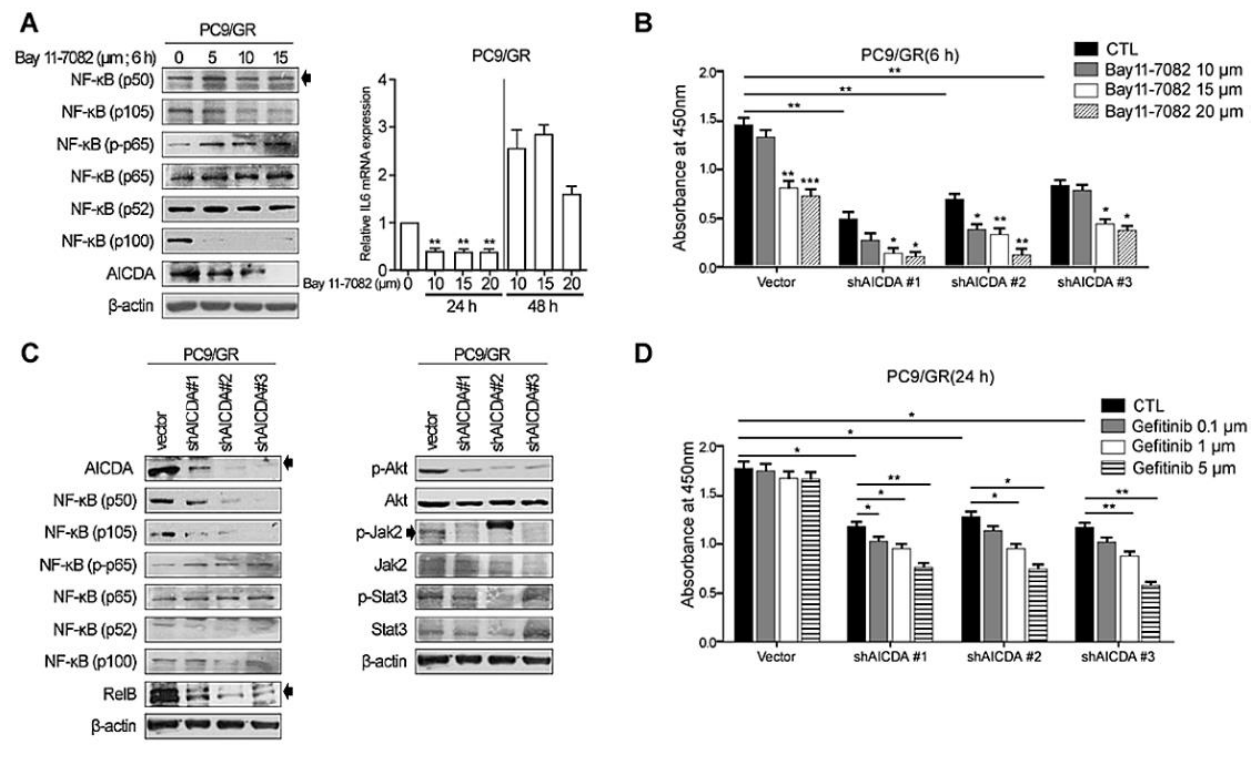
Figure 2. Knockdown of NF- κB and AICDA activity in EGFR -TKI-resistant lung adenocarcinoma cells. ( A ) Treatment of EGFR-TKI-resistant PC9/GR cells with an NF- κB inhibitor (Bay 11-7082), and changes in expression of ( A ) NF- κB components and IL -6. ( B ) Cell viability assay conducted after knockdown of AICDA. ( C ) Knockdown of AICDA and expression of NF- κB components, p -Akt, Akt, p-Jak2, Jak2, p-Stat3, and Stat3. ( D ) Cell viability assay conducted after knockdown of AICDA